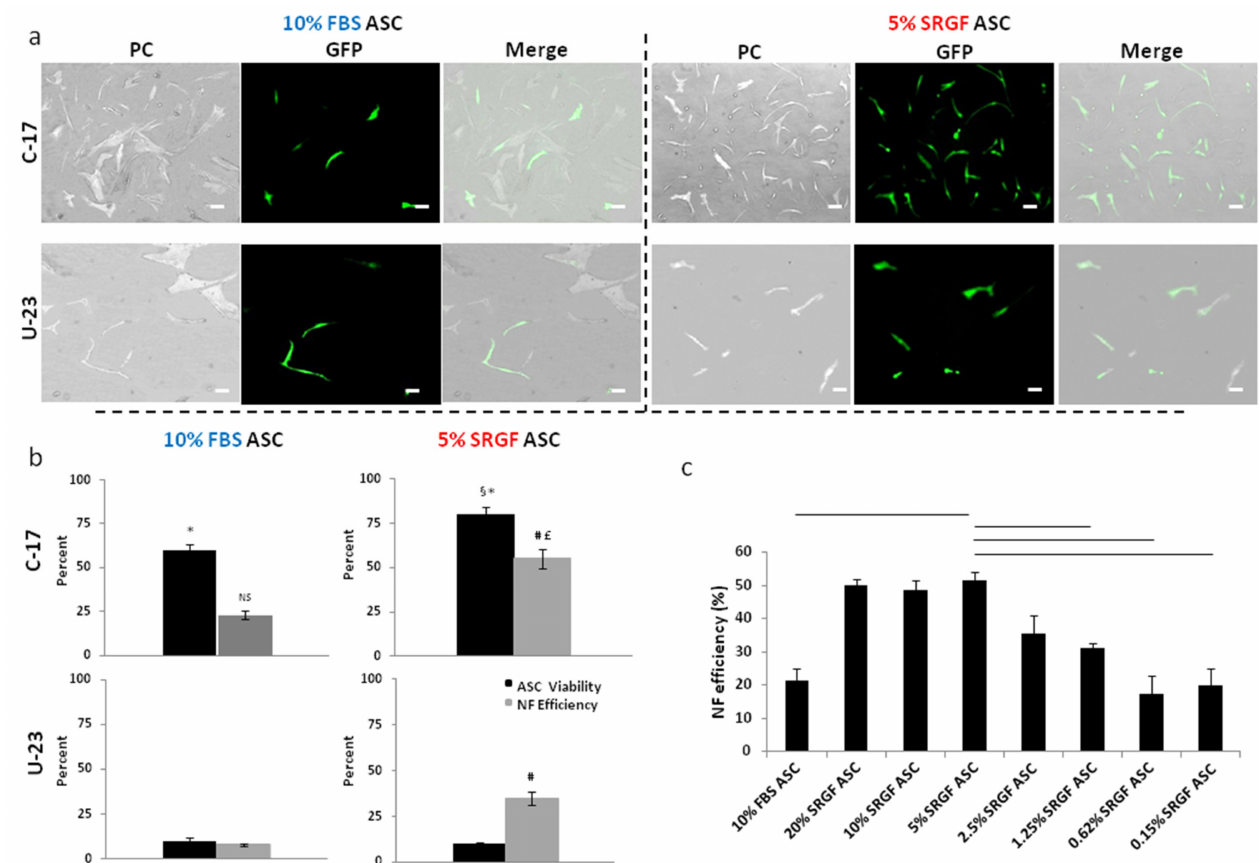
Figure 1. ( a ) shows representative images of 10% FBS and 5% SRGF ASC taken after NF performed by C-17 and U-23 electric pulse administration (protocol setup). Cell viability and transfection efficiency shown in ( b ) were calculated by image analysis as described in Methods. *, p < 0.001 vs. U-23 program; §, p < 0.01 vs. 10% FBS ASC; #, p < 0.01 vs. 10%